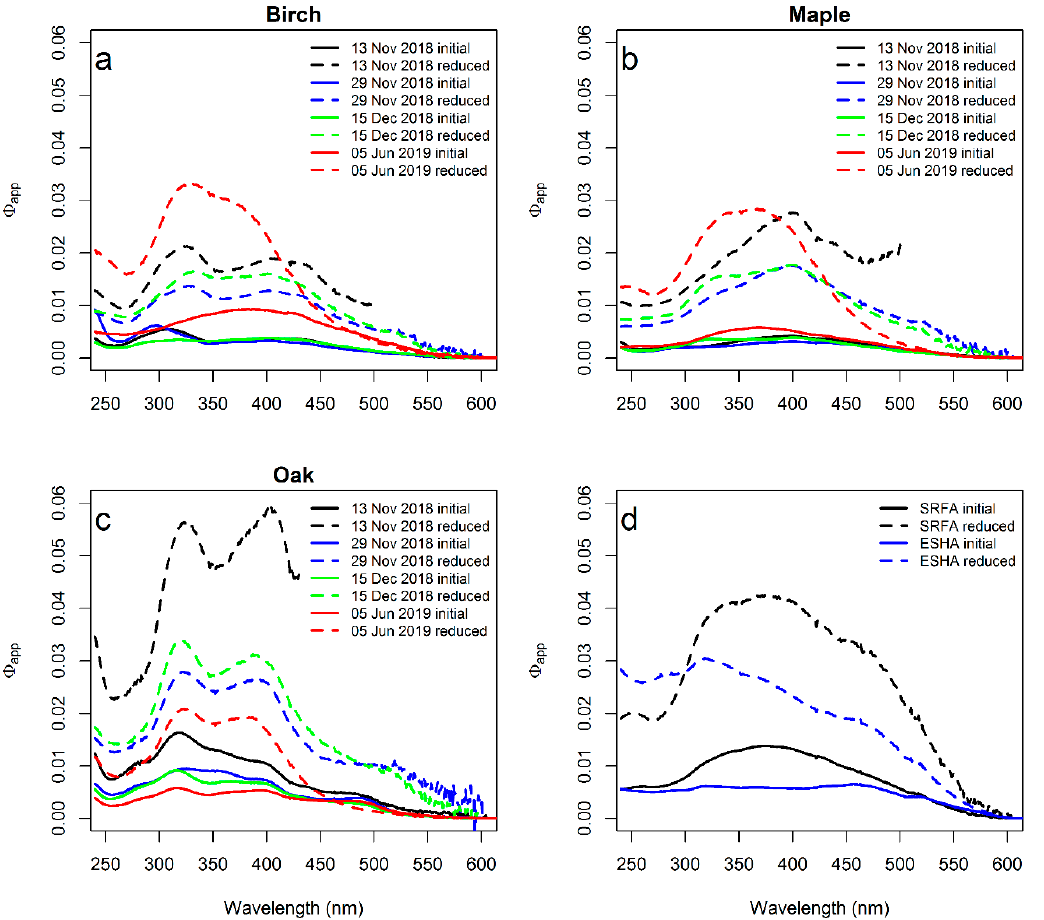
Figure 3. Apparent quantum yield ( Φ app ) before and after borohydride treatment (reduced) for ( a )